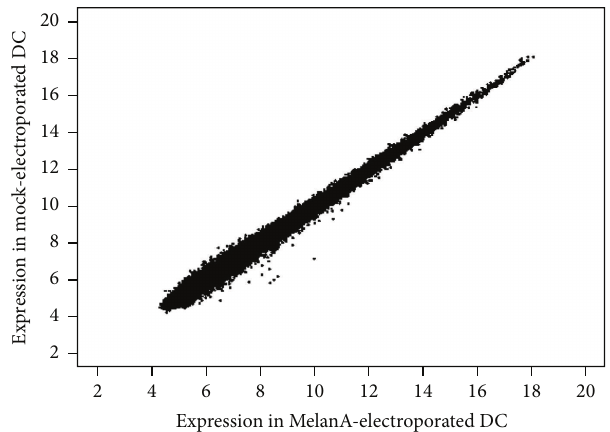
Figure 5: No difference in microarray analysis between mock- and MelanA-RNA-electroporated DCs. Scatter plot of the probe set expression levels for MelanA-RNA-electroporated DCs versus Mock-electroporated DCs samples. Data from 6 samples per exper- imental condition were processed for background correction and normalization. In the figure, the average probe intensity for each experimental condition is